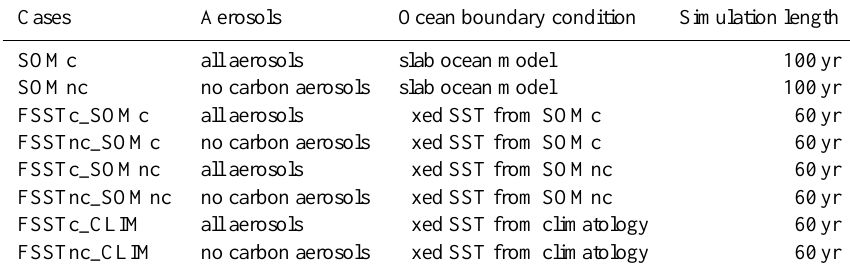
Table 1. Experiments conducted in this study. SOM stands for the slab ocean model run, followed by aerosol setting (lower case c/nc denotes simulation with/without carbonaceous aerosols). FSSTc_SOMc represents fixed sea surface temperature run with carbonaceous aerosols, where SST was obtained from SOMc (_SOMc). Similarly, FSSTnc_SOMc is the fixed sea surface temperature run without carbonaceous aerosols, where SST was obtained from SOMc. _CLIM denotes climatology SST was used in the experiments.